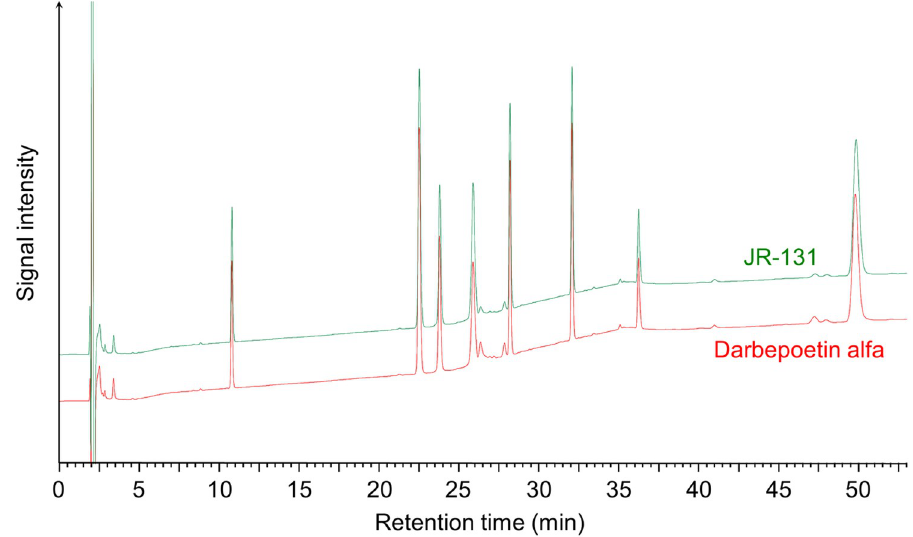
Fig 1. Peptide mapping profiles of JR-131 and darbepoetin alfa. Representative profiles of JR-131 (green) and darbepoetin alfa (red) are presented.